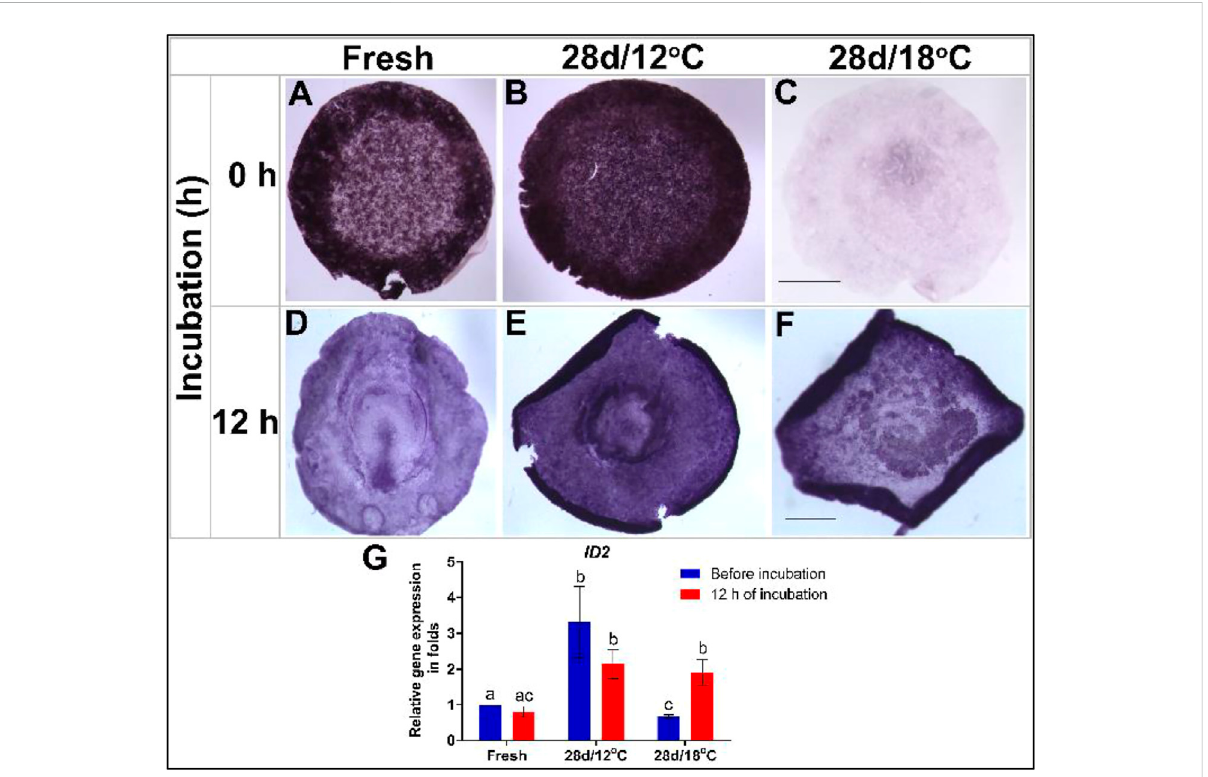
FIGURE 3 Expression of ID2 gene in embryos following storage, and following 12 h of incubation in the resumption phase. (A – C) ID2 gene expression in freshly laid embryo (X EG&K), embryo stored for 28 days at 12 ° C (XII EG&K), and embryo stored for 28 days at 18 ° C, respectively. (D – F) ID2 gene expressionduring12 hofresumptionphaseofembryos. (G) Quanti fi cationof ID2 geneexpressionin6differentembryogroupsusingreal-timePCR. GAPDH wasusedforgeneexpressionnormalizationandthedetermined ID2 expressioninthegroupsisrepresentedasafoldofchangerelative to the fresh control. One-way ANOVA analysis of 6 different embryo groups-different connecting letters denote that the expression of ID2 is signi fi cantly different between groups; F value = 11.83; Fresh (before incubation) vs. 28 days/12 ° C (before incubation), a vs. b: p = 0.0061; Fresh (before incubation) vs. 28 days/18 ° C (before incubation), a vs. c: p = 0.0079; 28 days/18 ° C, b vs. c: p = 0.0032; 28 days/12 ° C (before incubation) vs. 28 days/18 ° C (before incubation), b vs. c: p = 0.0002. Bar = 1